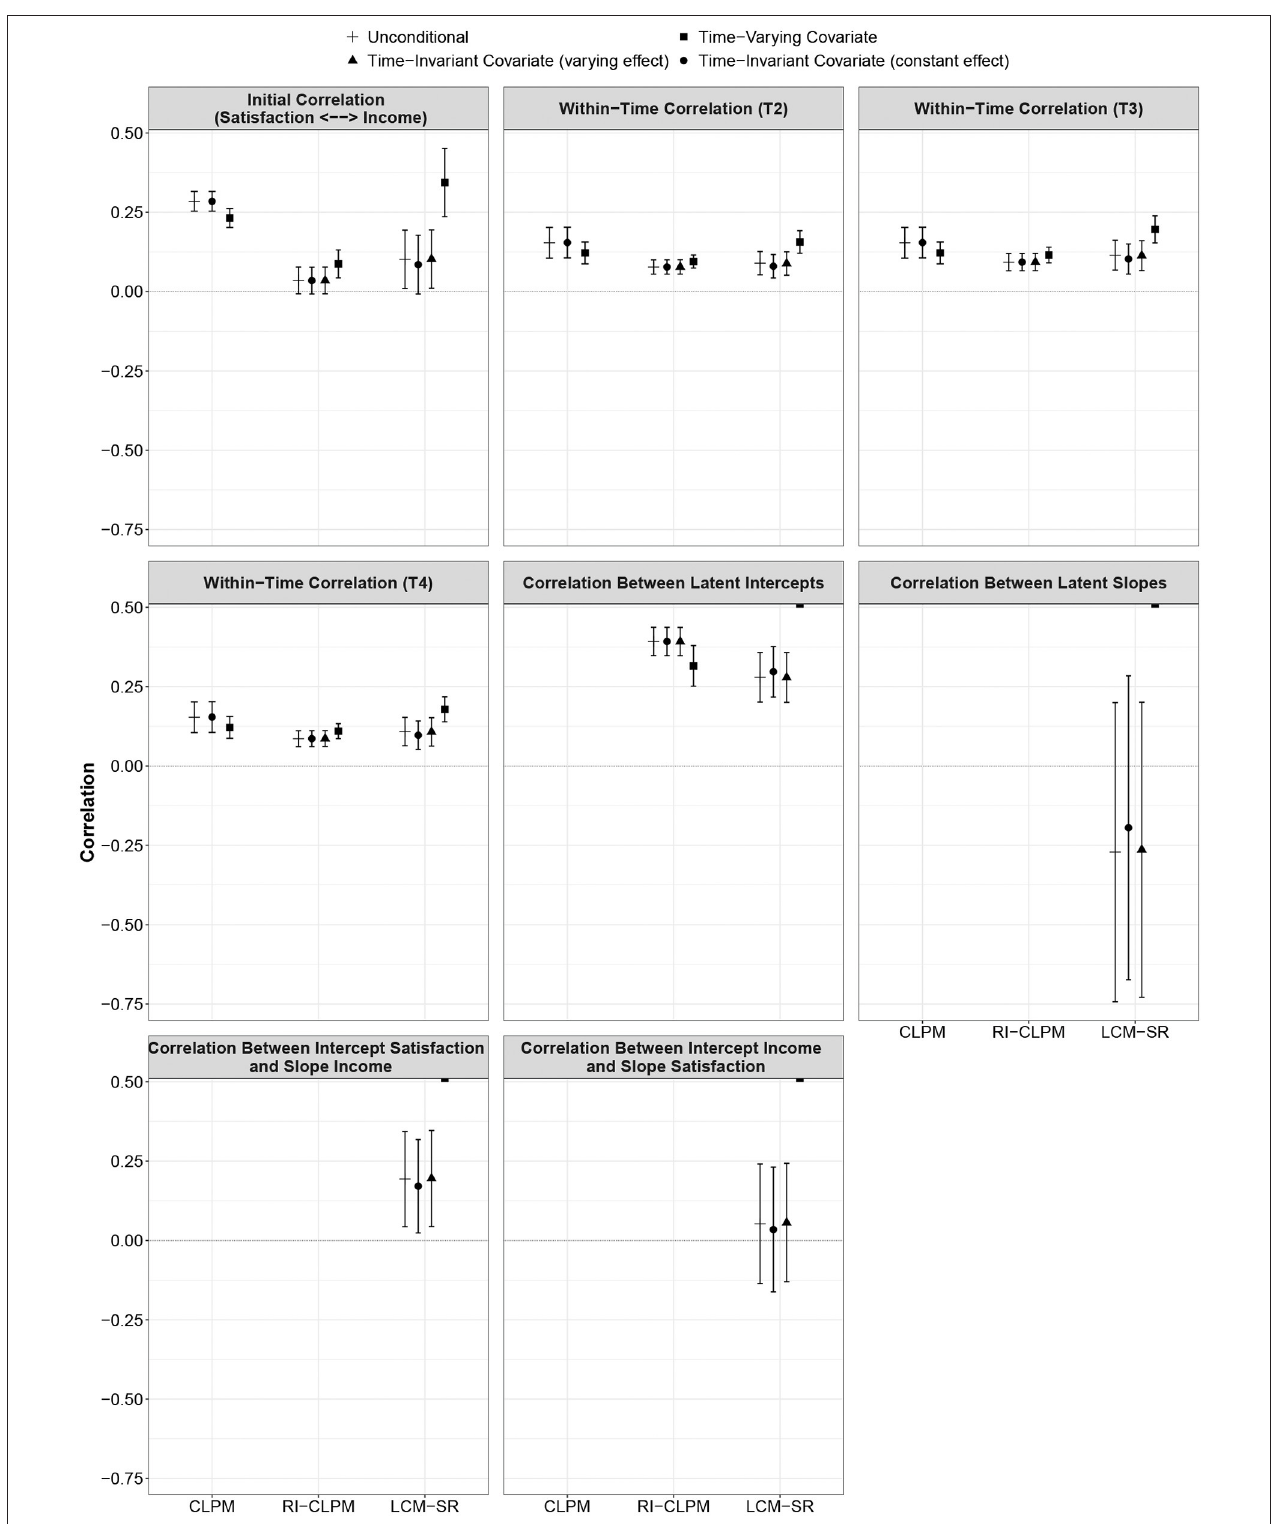
FIGURE 5 | Comparison of correlations across model specifications (unconditional, TIC, TVC) and between models (CLPM, RI-CLPM, LCM-SR). Error bars indicate 95% confidence intervals. Figure is available under a CC-BY 4.0 license at https://osf.io/8mvu5/.